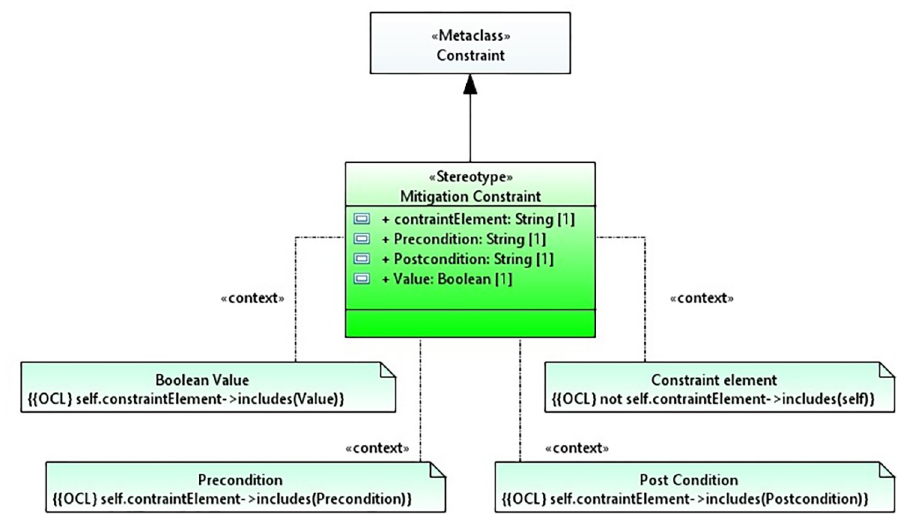
Fig 4. Mitigation